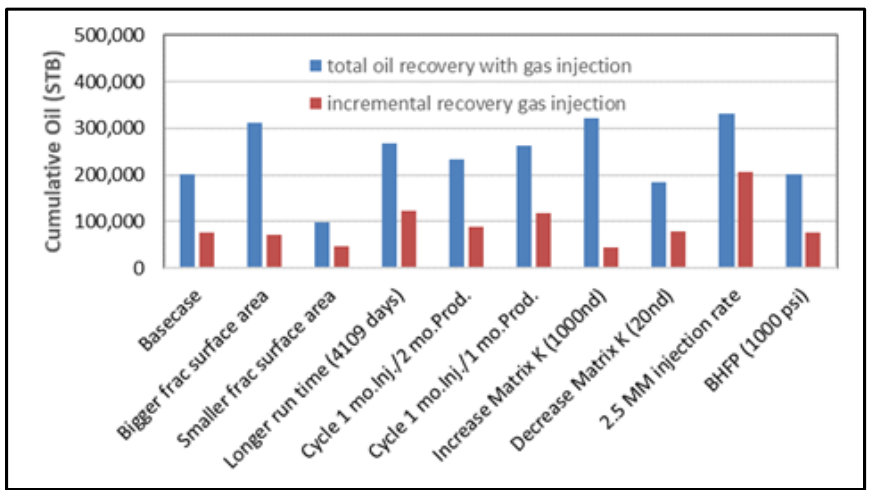
Figure 18. Total oil (blue) and incremental oil (red) recovered at end of model due to gas injection Figure18. Totaloil(blue)andincrementaloil(red)recoveredatendofmodelduetogasinjectionprocess. process.